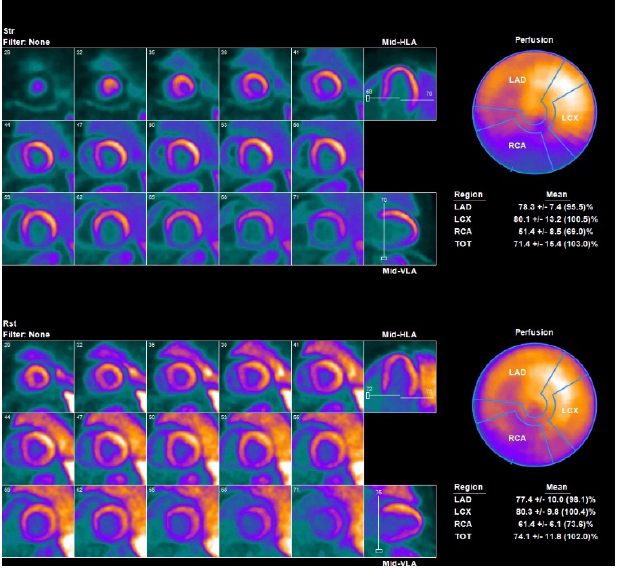
Figure 2. Assessment of myocardial perfusion with 13N-ammonia-PET. Top rows represent stress acquisition and lower rows rest acquisition. Myocardial perfusion is markedly decreased in the inferior wall during stress, compatible with ischemia in this territory. Image source: Institute for Nuclear Sciences Applied to Health (ICNAS).